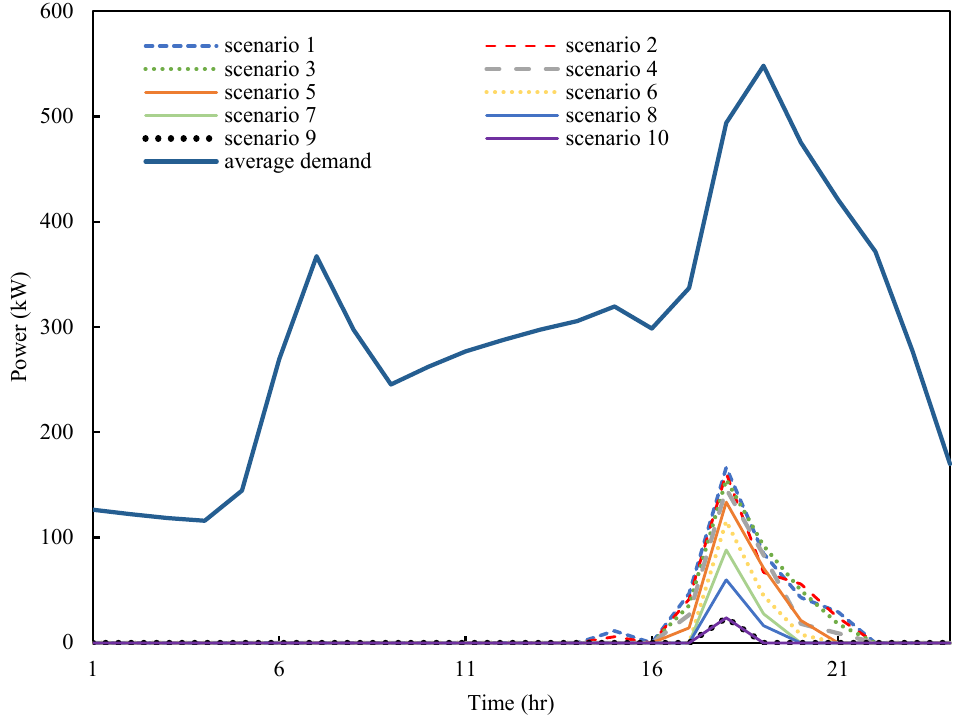
Figure 17. Average discharging power per stochastic scenario.